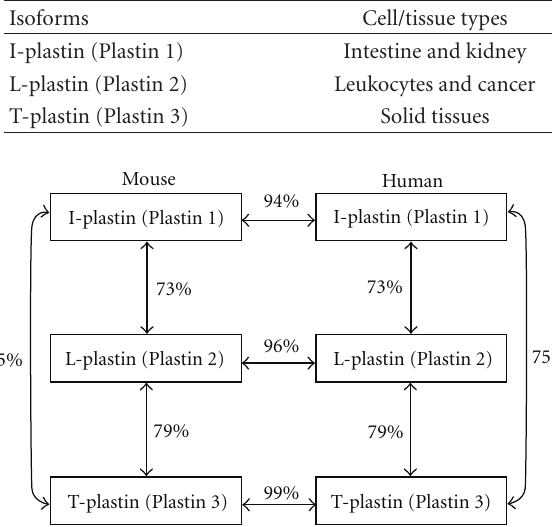
Table 1: Plastin isoforms expressed in distinct cell types.